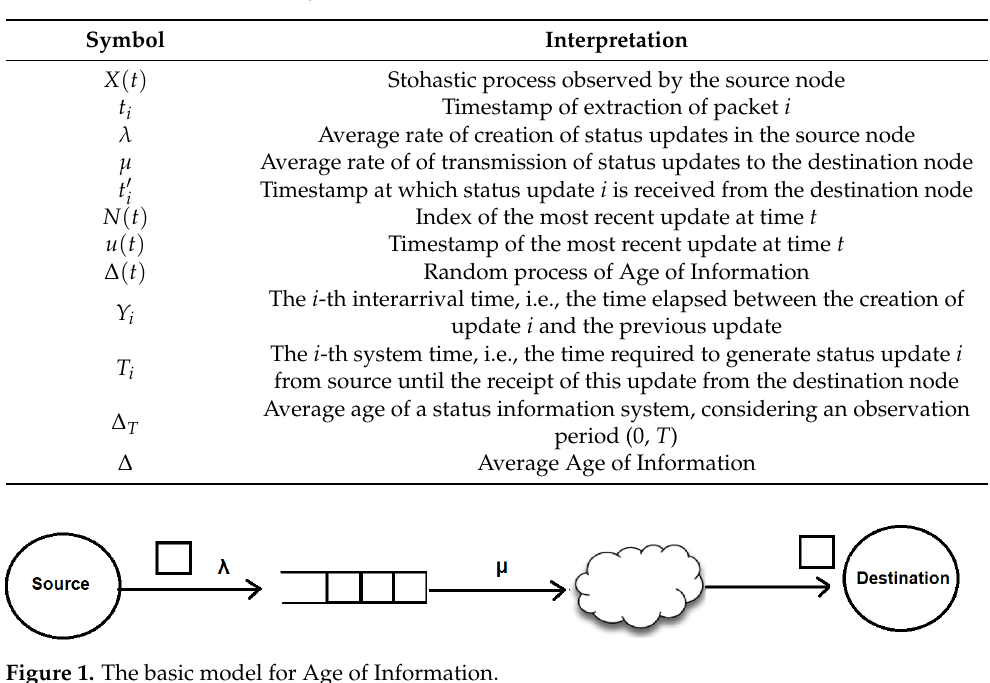
Table 1. List of mathematical symbols used in this work.